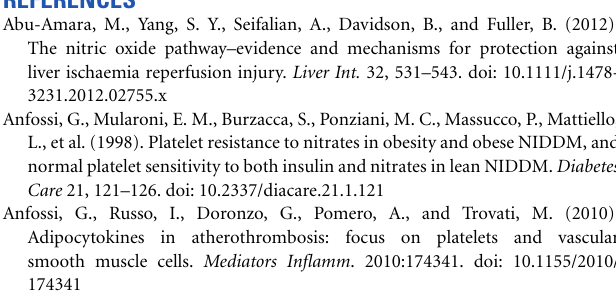
and IL-1 β exert NO-independent anti-aggregation effects on iso- lated human platelets independently on the presence of insulin resistance in the